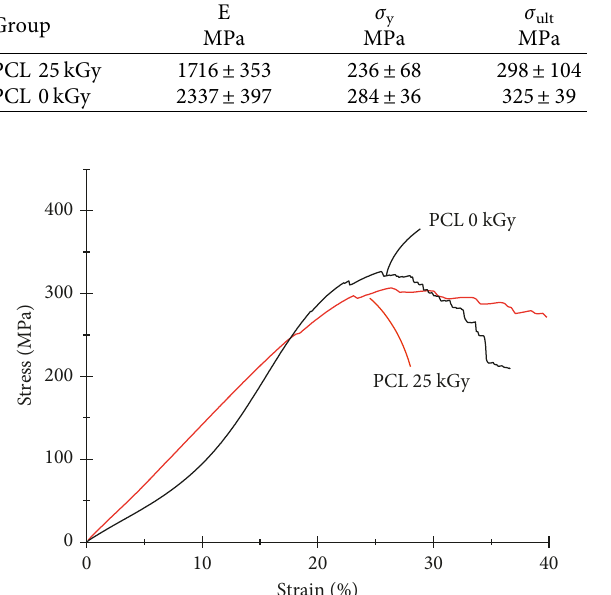
Table 6: Parameters obtained for different groups after tensile test.